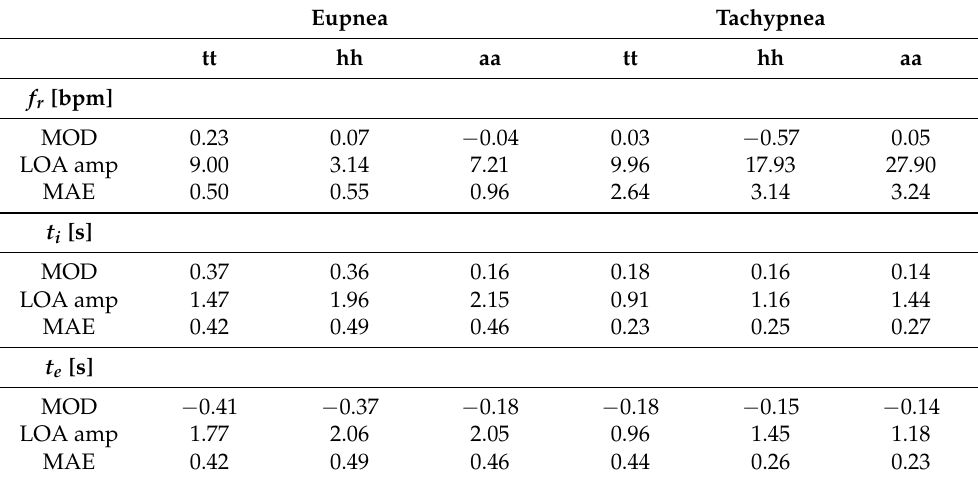
Table 3. MOD, LOA amp, and MAE values obtained for the performed BA analyses. The BA analyses were performed on the total (tt), healthy side (hh), and affected side (aa) respiratory signals. Eupnea Tachypnea tt hh aa tt hh aa f r [bpm] MOD 0.23 0.07 − 0.04 0.03 − 0.57 0.05 LOA amp 9.00 3.14 7.21 9.96 17.93